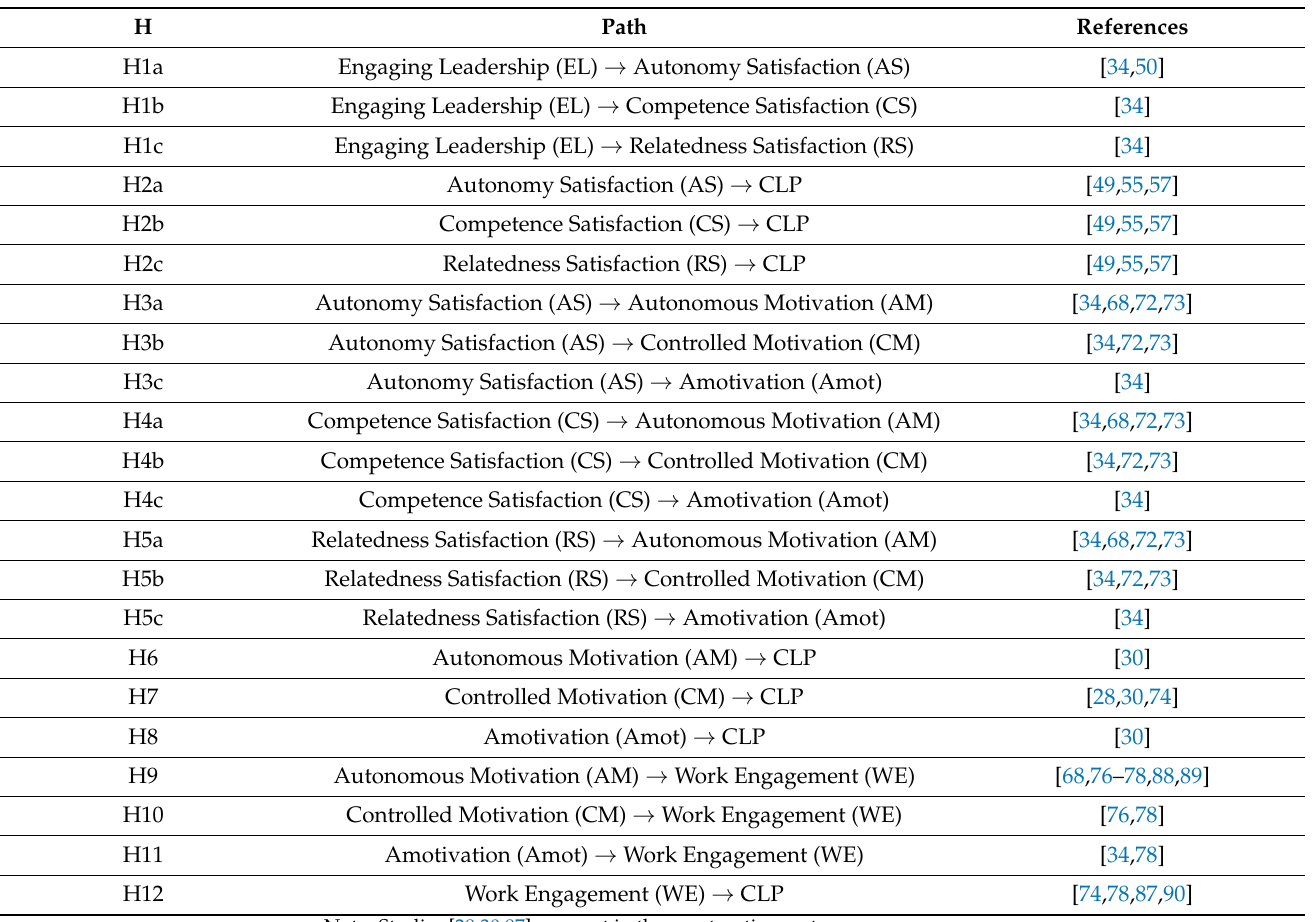
Table 1. The study’s